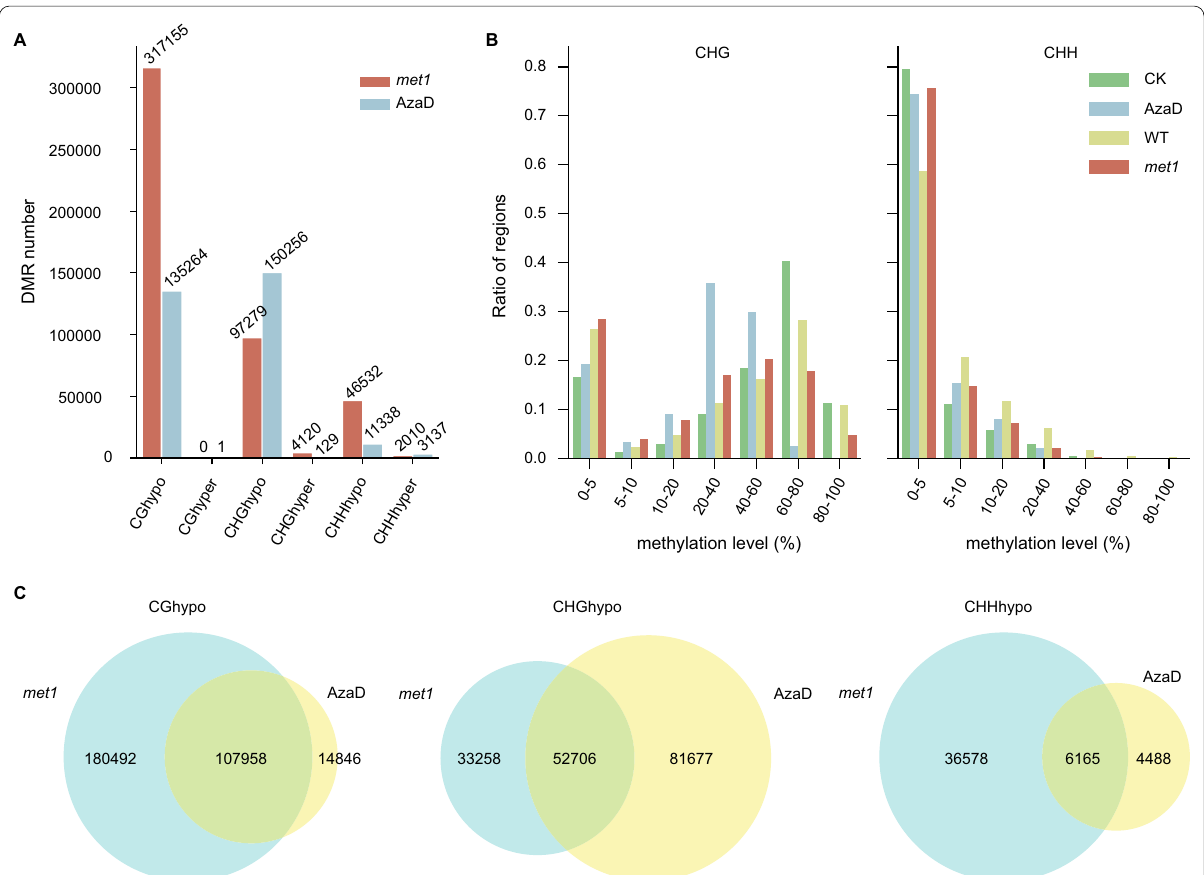
Fig. 2 Identified DMRs in AzaD treated and osmet1-2 mutant rice. a Number of identified DMRs. DMRs in AzaD treated rice were identified relative to the Kitaake cultivar (CK). DMRs in osmet1-2 mutants were identified relative to the Nipponbare cultivar (WT). b Frequency distribution of CHG and CHH methylation levels in CG hypo DMRs. The loss of CG methylation was accompanied by the loss of CHG and CHH methylation. c Venn diagrams show the DMR overlap ratio between AzaD treated and osmet1-2 mutant rice. DMRs located in the collinear regions identified between genomes of Kitaake and Nipponbare rice cultivars were